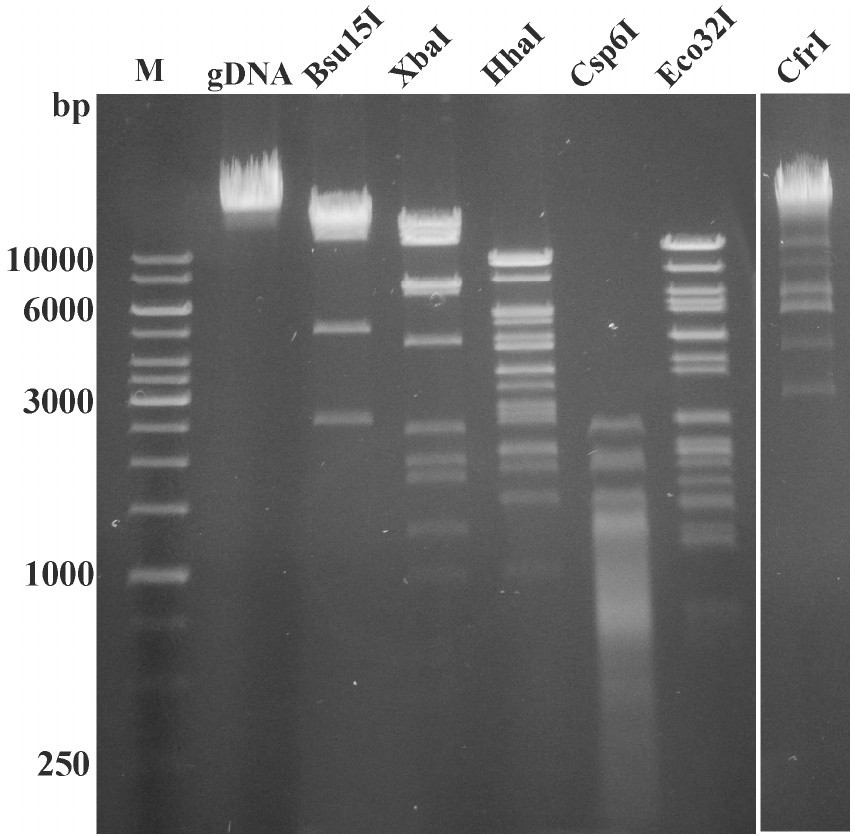
Figure 3. Restriction digestion patterns of phage VpaE1 genomic DNA (gDNA). Lane M represents GeneRuler™ 1 kb DNA Ladder (Thermo Fisher Scientific).